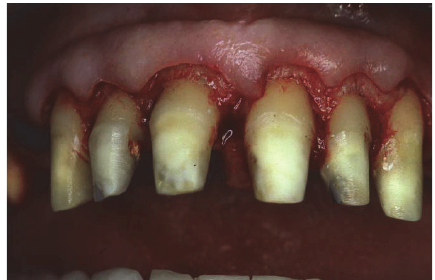
Figure 9: Coincidence between centric occlusion and maximum intercuspation and determination of the incisal plane.